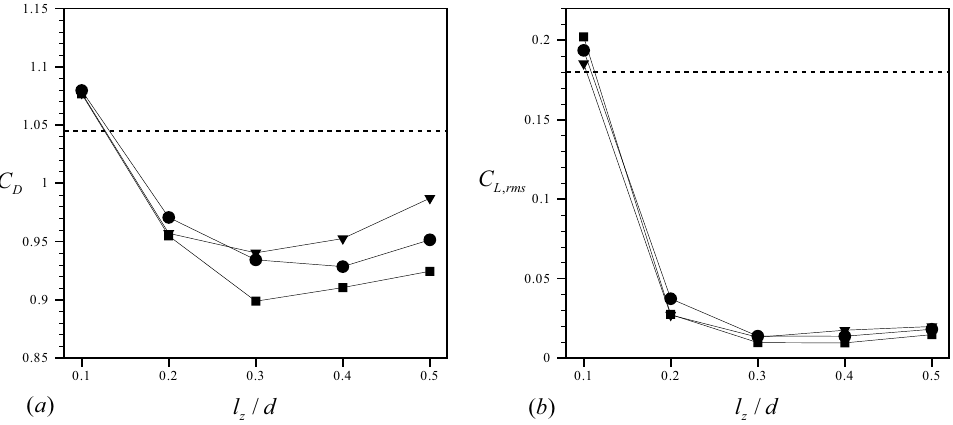
Figure 4. Variations of drag and lift coefficients with the tab height ( l y ) and width ( l z ) ( λ z / d = 4): ( a ) mean drag coefficient; ( b ) rms of lift coefficient. (cid:4) , l y / d = 0.2; • , l y / d = 0.3; (cid:72) , l y / d = 0.4. Here, dashed lines denote values for the uncontrolled flow.